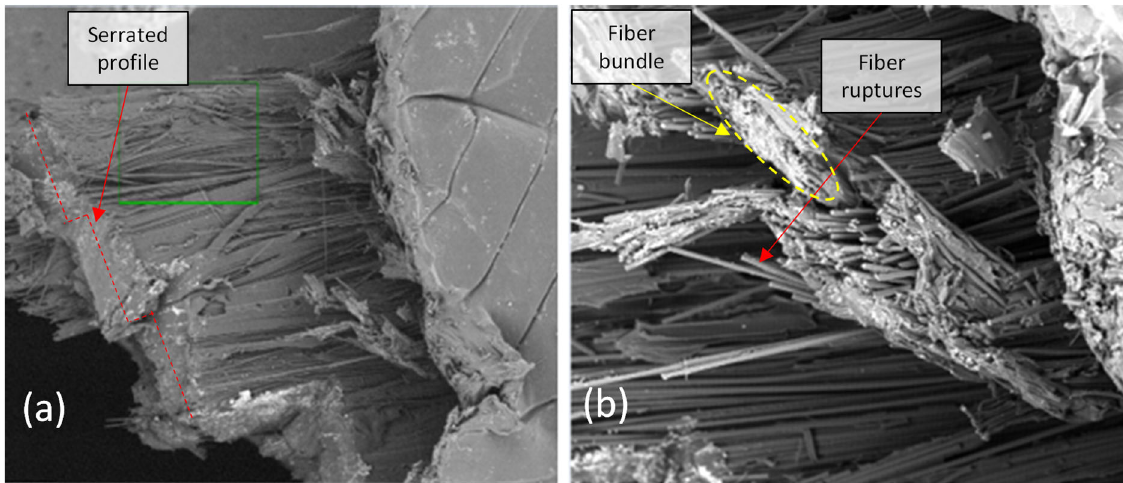
Figure 16. SEM fractography of a tensile test for a 90° reinforced specimen. ( a ) 100× magnification, ( b ) 400× magnification.